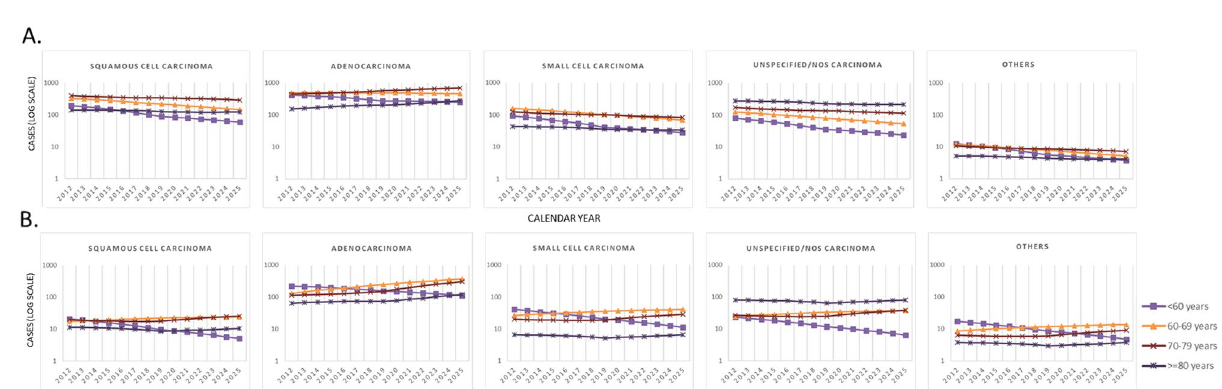
Figure 2. Incidence of lung cancer in men ( A ) and women ( B ) in Catalonia between 2012 and 2025 by histology and age group. NOS: not otherwise specified. Others: This group contains several histological types